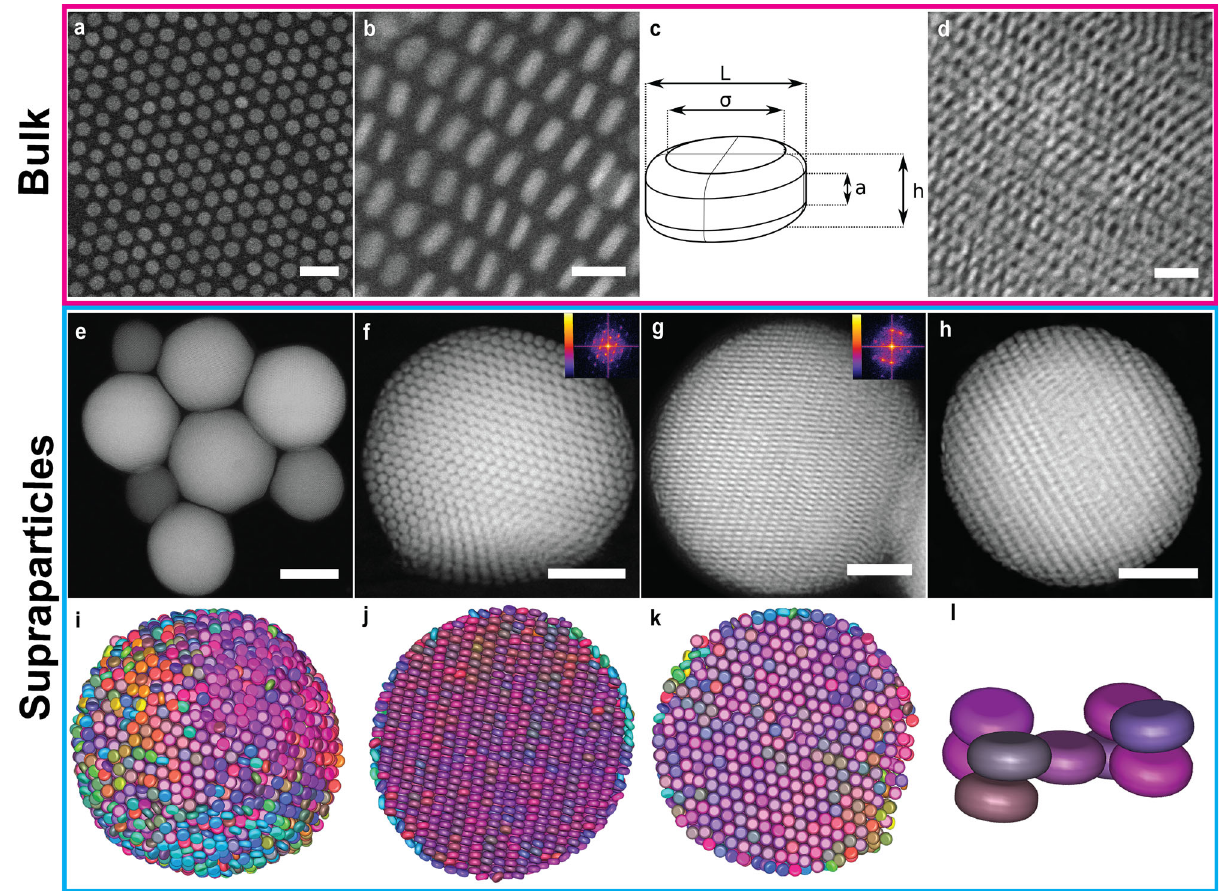
g a SP where the NPLs orient their edges against the con fi ning interface, showing interdigitation between adjacent columns. h 2DHAADF-STEMimage of a SPwith a diameter of 160nm used for electron tomography and corresponding 3D visuali- zation of the i surface termination and j , k cross-section structure as viewed j perpendiculartoand i , k alongthecolumnstackingdirection,respectively. l ABCO unitcell extracted from the reconstruction. Scale bars, a 20nm, b 10nm, d 20nm, e 200nm, f – h 50nm. Insets in f , g: corresponding fast Fourier transform (FFT) patterns. For an interactive 3D view of the SP, see Supplementary Data